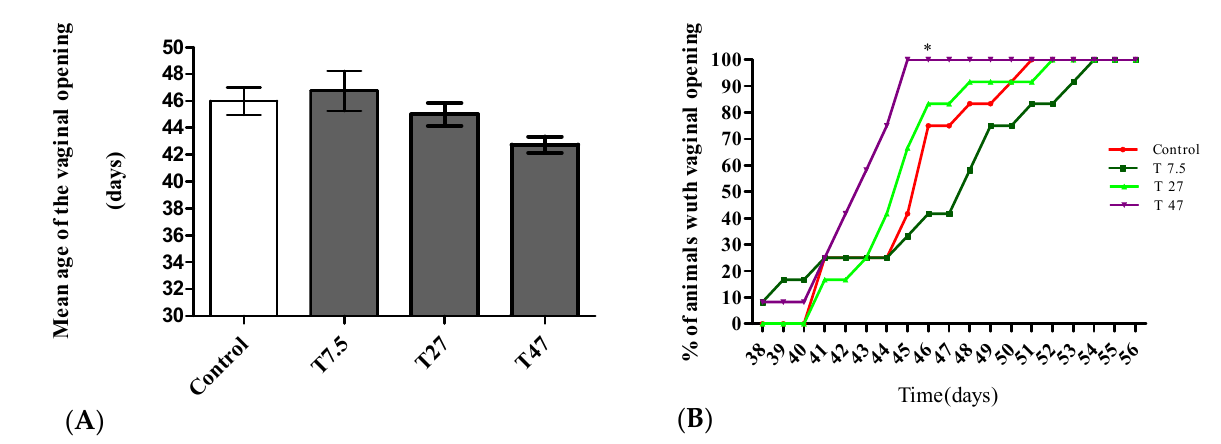
Figure 2. Effects of tartrazine on the mean age of the vaginal opening ( A ), the percentage (%) of rats with a vaginal opening ( B ) during 40 days of treatment. Control = animals receiving vehicle (distilled water, 10 mL/kg BW); T = rats treated with tartrazine at dose of 7.5; 27, and 47 mg/kg BW. Results are shown as a mean ± SEM, n = 5. *: p < 0.05 in reference to control.